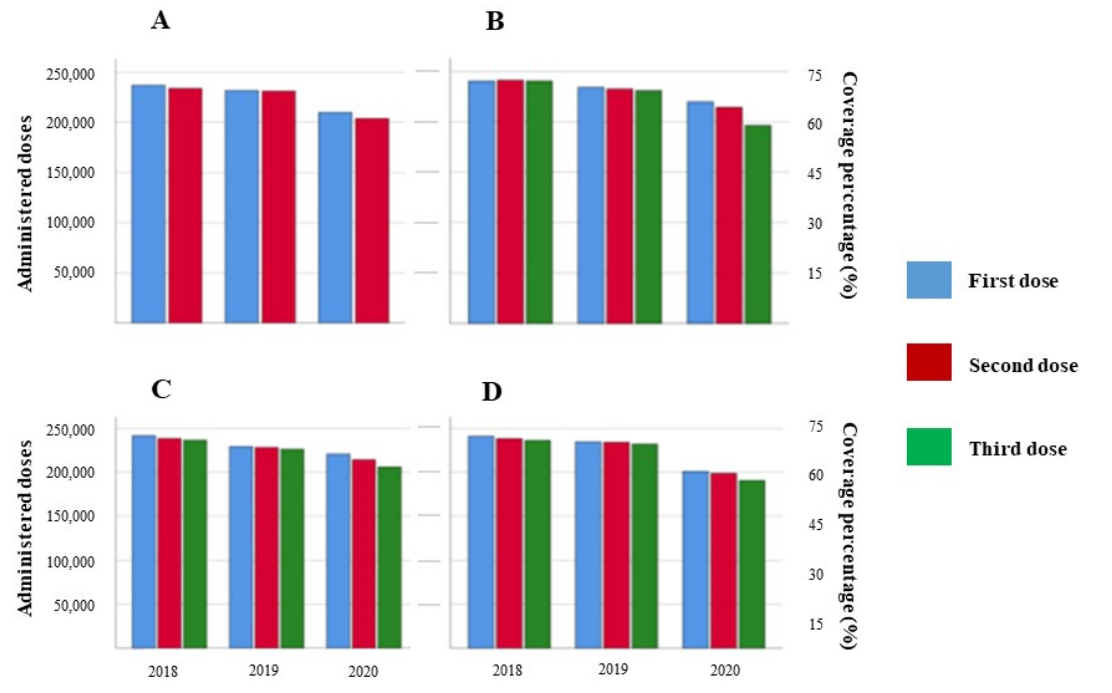
Figure 2. Changes in administered vaccination doses and coverage percentages. The graph